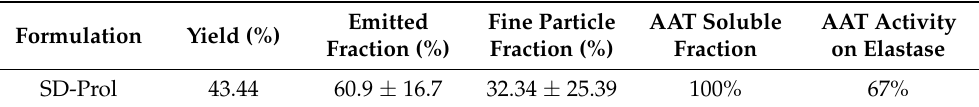
Table 5. Characteristics of the powder prepared from solutions of plasma-derived AAT with L-leucine and mannitol as a bulking